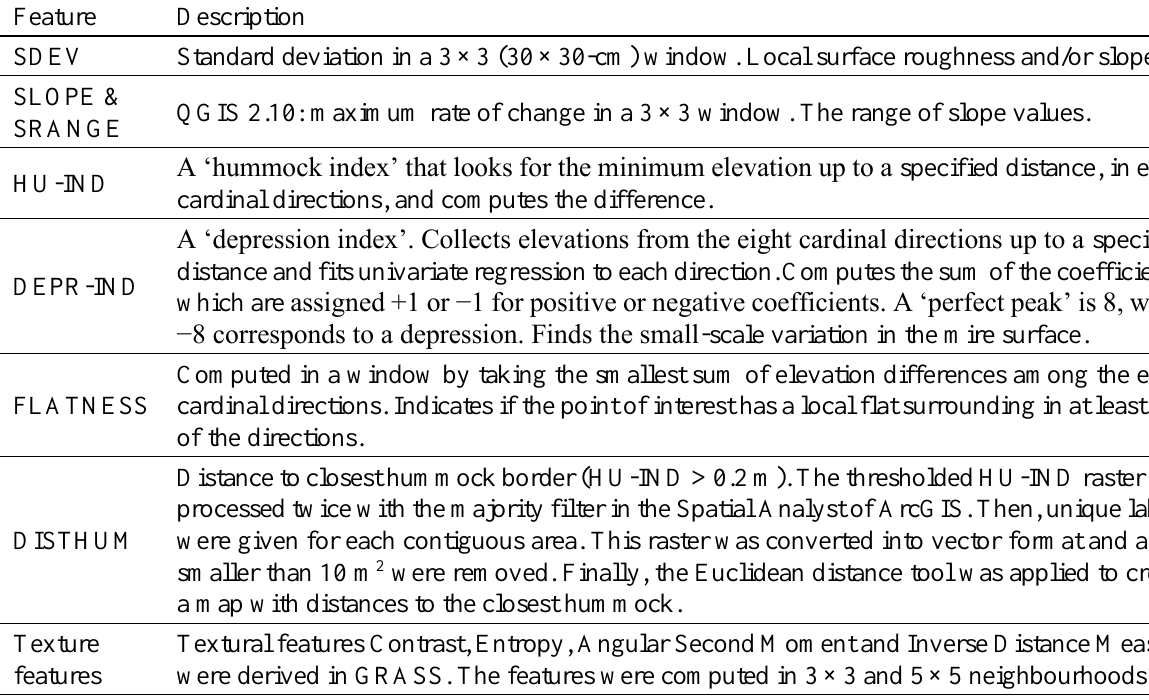
Table 4. DEM features implemented in QGIS (Quantum GIS Development Team 2015), ArcGIS (ESRI Inc., Redlands, CA, USA), GRASS GIS (GRASS Development Team 2015), or on an in-house photogrammetric